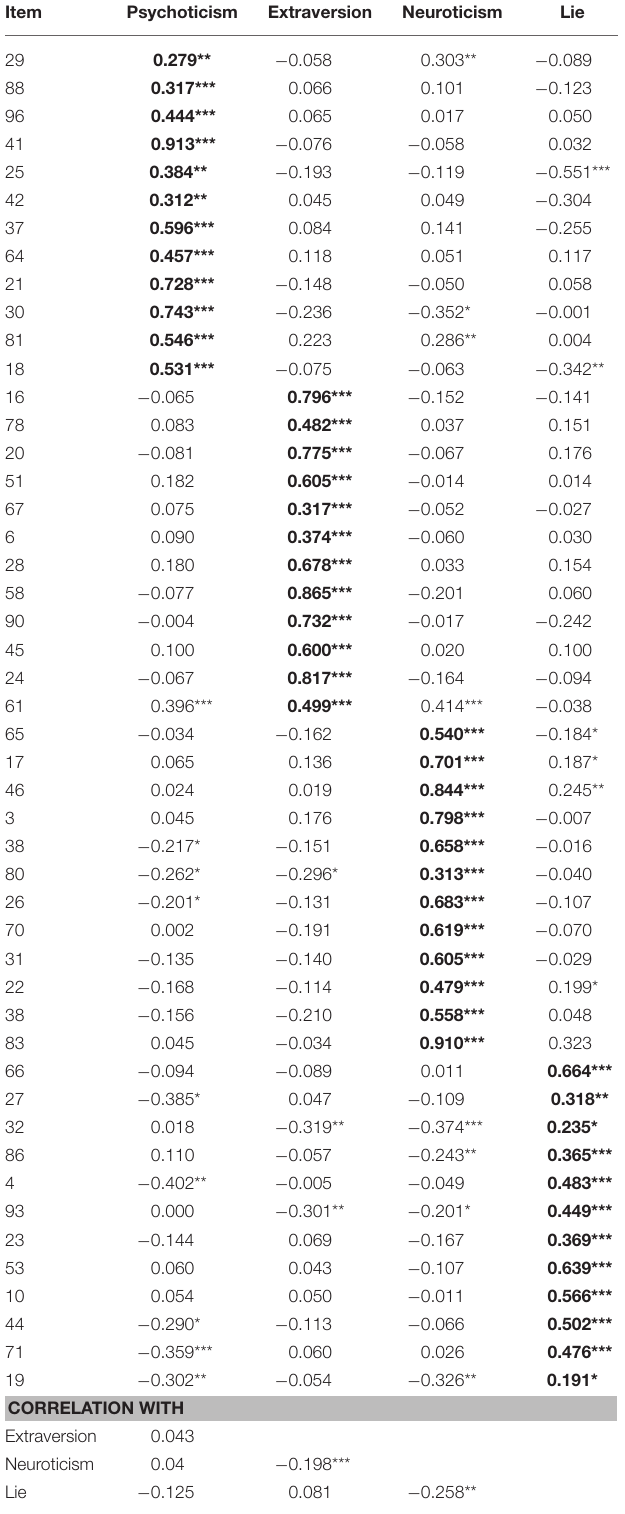
TABLE 6 | Exploratory structural equation